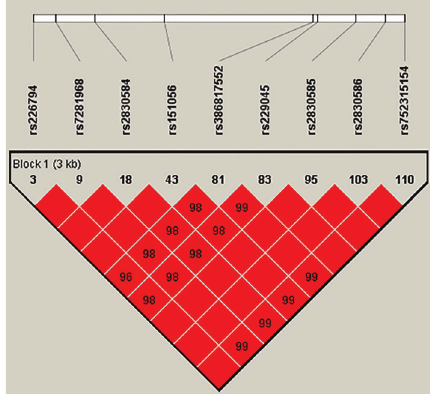
Figure 3. Linkage disequilibrium of the 9 SNPs in ADAMTS5